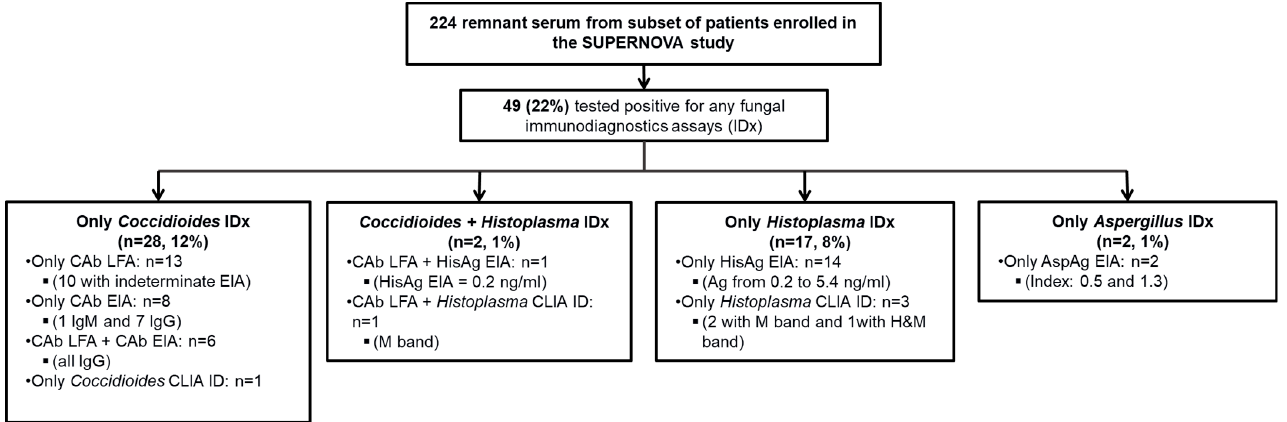
Figure 1. Flow chart of specimens tested and results. (ID) immunodi ff usion; (CAb LFA) S ō na Coccidioides Ab lateral fl ow assay; (CAb EIA) Clarus Coccidioides Ab enzyme immunoassay (CAb EIA); (HisAg EIA) Clarus Histoplasma galactomannan EIA (HisAg EIA); (AspAg EIA) Platelia Aspergillus kit. Table 1. Characteristics of 224 hospitalized patients with acute respiratory illness.